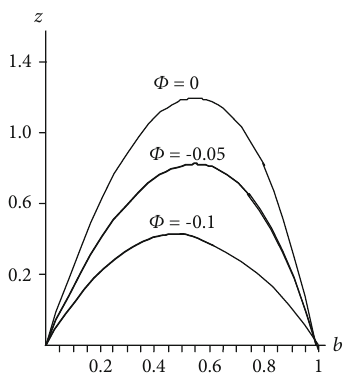
Figure 10: Velocity of Z when N = 0 : 5 , R = 2 : 5 . Table 1: Numerical values of ψ and R R , and ji ′ with j = 1 : 0 , y = 1 : 0 , L = 0 : 7 , μ = 1 : 0 , f